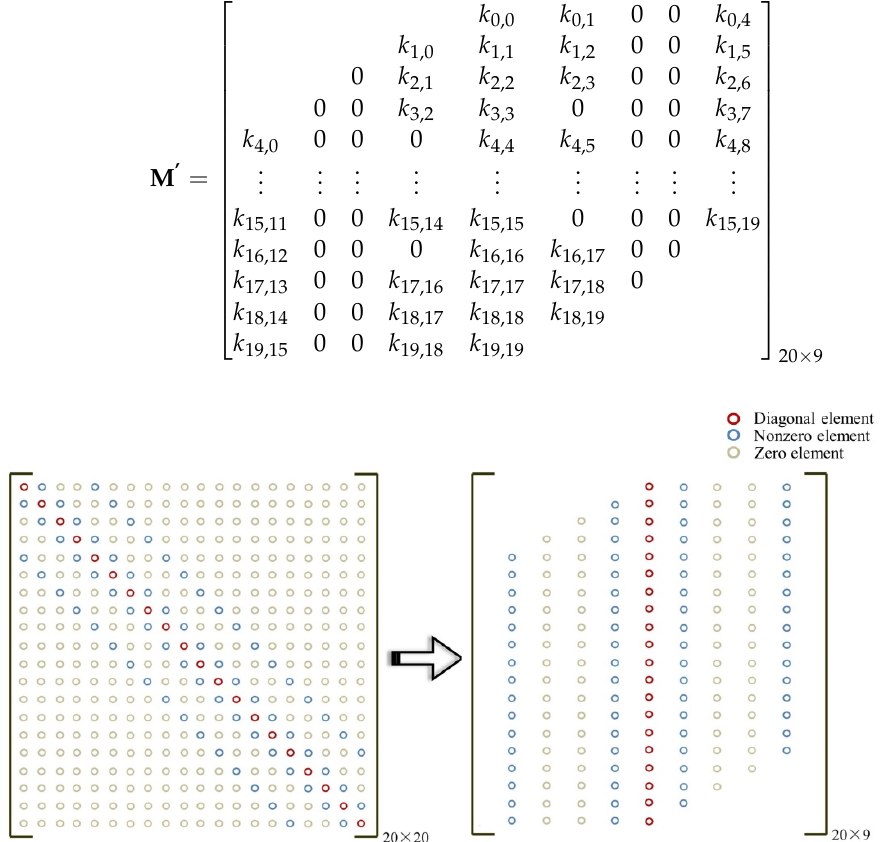
Table 1. Comparison of the coefficient matrix